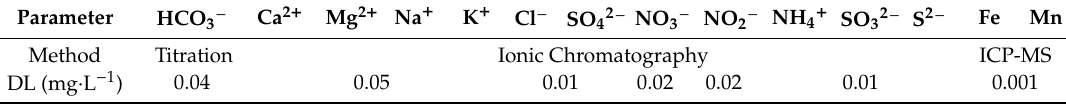
Table 2. Analytical methods and detection thresholds for the analyzed elements (mg · L − 1